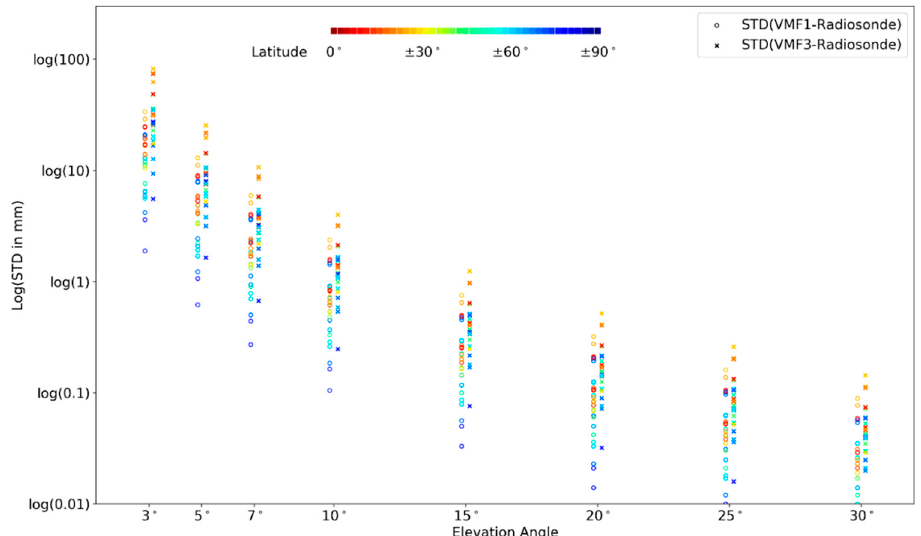
Figure 14. Standard deviations of VMF3 / VMF1 SWD biases with reference to radiosonde SWD estimates from ray-tracing in mm. Cross marks stand for VMF3 SWD biases, and circle marks stand for VMF1 SWD biases (they are plotted with a small horizontal shift to avoid covering). The color bar indicates the station